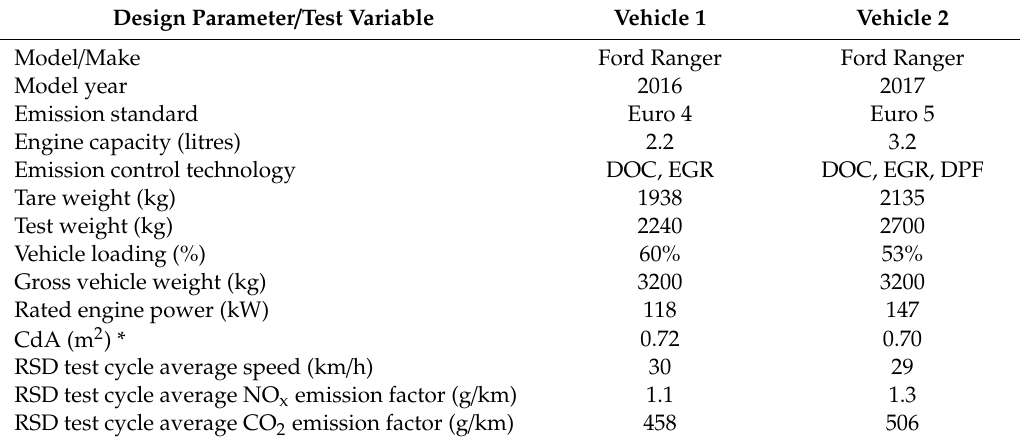
Table 1. Test vehicle specifications and selected dynamometer test